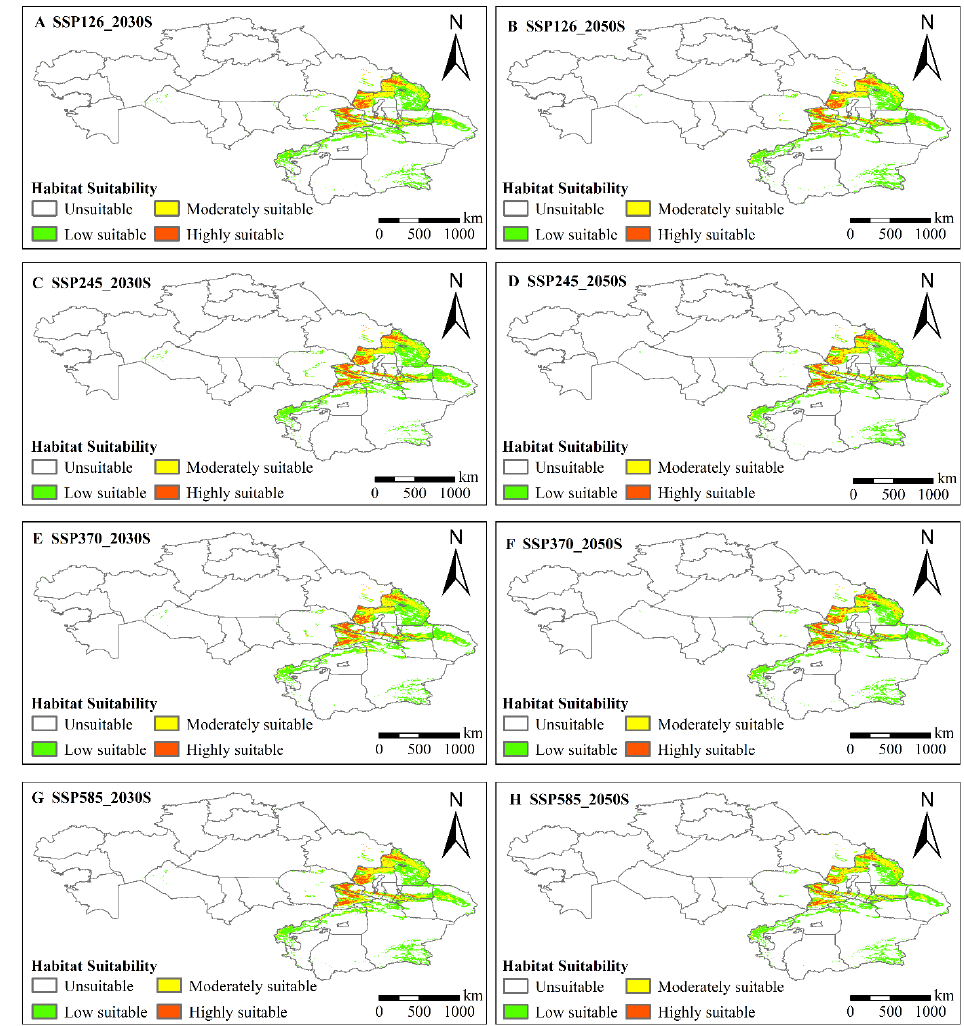
Figure 4. ( A – H ) Typical locust potential habitat projections for two time periods (the 2030s and 2050s) under four climate scenarios (SSP126, SSP245, SSP370, and SSP585).